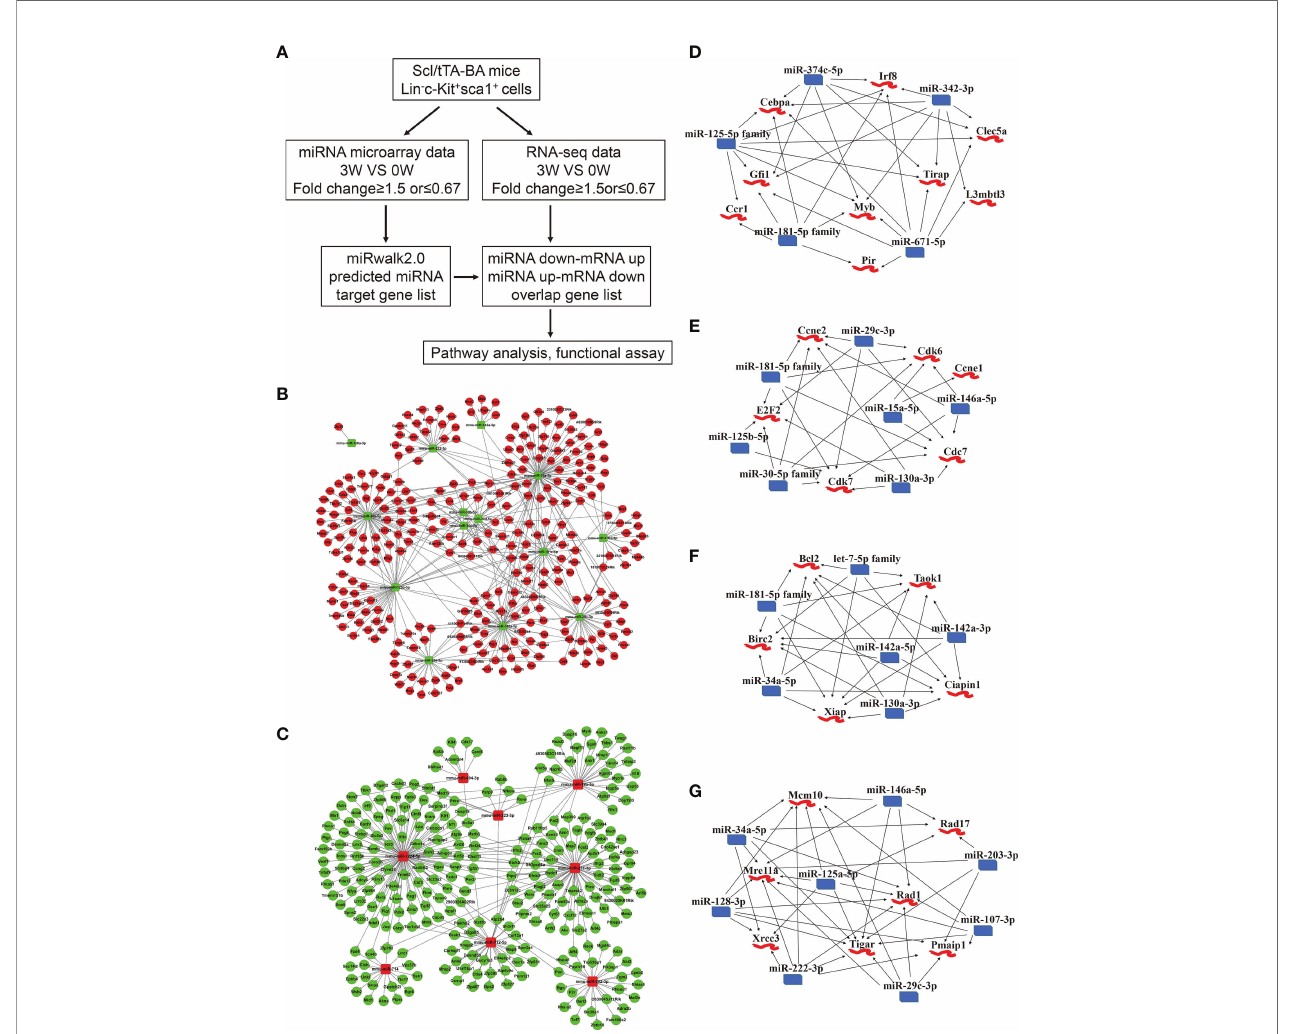
FIGURE 3 | Integrated analysis of miRNA-mRNA regulatory networks in murine CML LSKs. (A) Integrated analysis fl owchart of the screened miRNAs and predicted target genes. (B, C) The correlation networks showing 431 interactions built between 14 downregulated miRNAs and 299 possible target genes (B) , and 318 interactions between 8 upregulated miRNAs and 271 possible target genes (C) . (D – G) Visualization of the regulatory networks enriched for four pathways including myeloid differentiation (D) , cell cycle (E) , anti-apoptotic pathway (F) , and DNA damage (G)